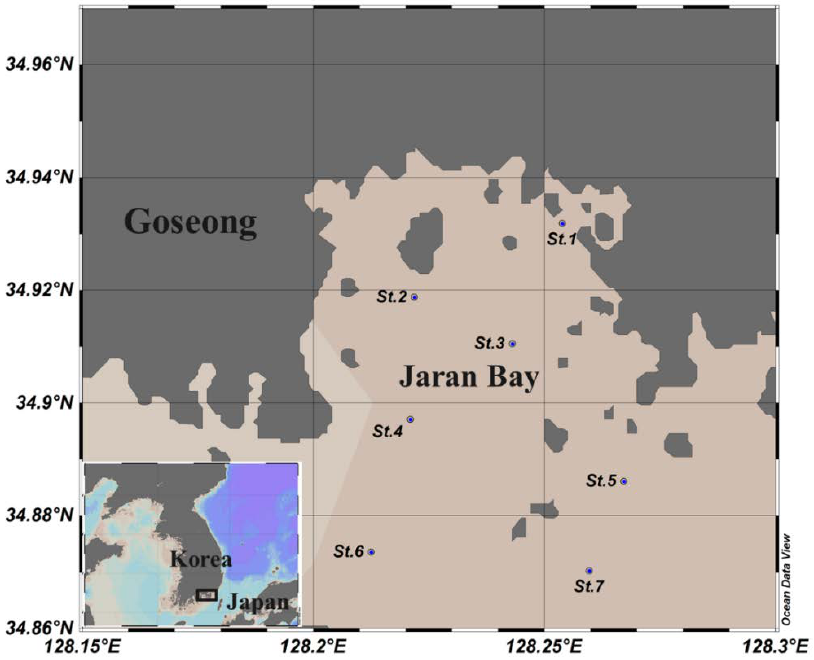
Figure 1. Study area map with the sampling stations in Jaran Bay, Korea.